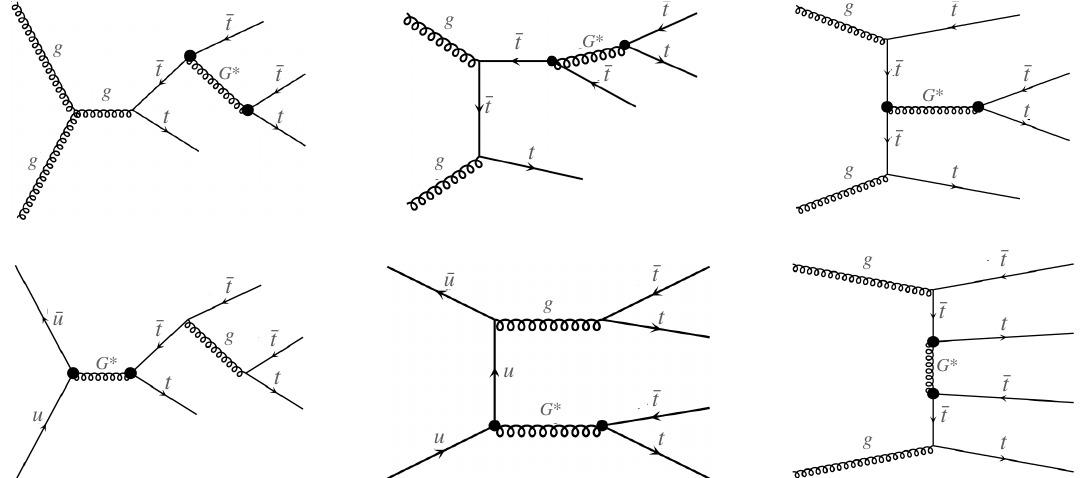
Figure 13 . A representative subset of Feynman diagrams of the process pp → tt ¯ t ¯ t mediated by a KK gluon. These are only 6 of the 544 diagrams containing a single KK gluon out of a total of 1920 involved in the process.